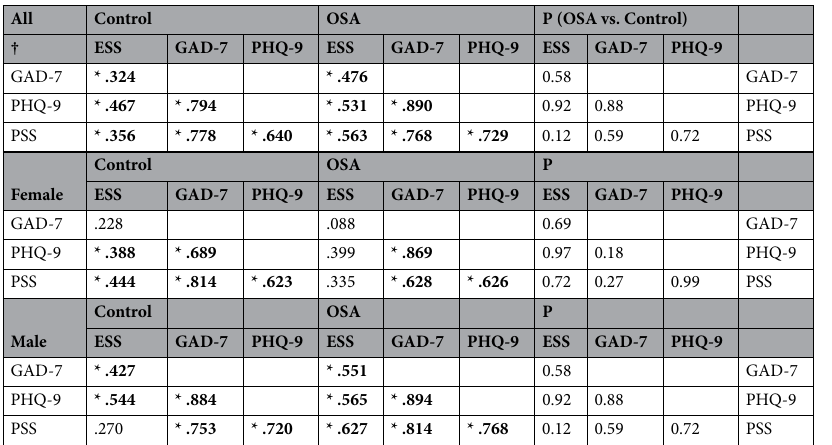
Table 2. Correlation table for symptoms. OSA and control group Pearson’s correlation values are shown for OSA and control groups separately for combined-sex (All), female and male. * = significant correlation ( P ≤ 0.05). Between-group P-values based on z-score comparisons of correlation coefficients. † ESS